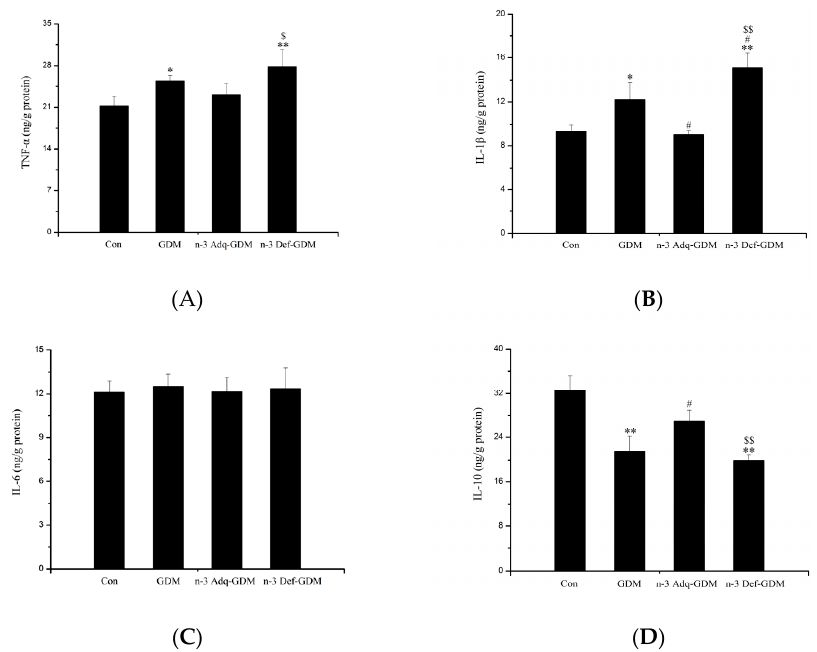
Figure 4. Inflammatory biomarkers in the liver of gestational diabetes mellitus (GDM) offspring at 11 months of age and the effect of n-3 polyunsaturated fatty acids (n-3 PUFA) on inflammatory biomarkers. ( A ) TNF- α , ( B ) IL-1 β , ( C ) IL-6, ( D ) IL-10. Bars are mean ± SD. n = 8 rats/group. * p < 0.05, ** p < 0.01, vs. Control o ff spring (Con); # p < 0.05, vs. GDM o ff spring (GDM); $ p < 0.05, $$ p < 0.01, vs. n-3 Adequate-GDM o ff spring (n-3